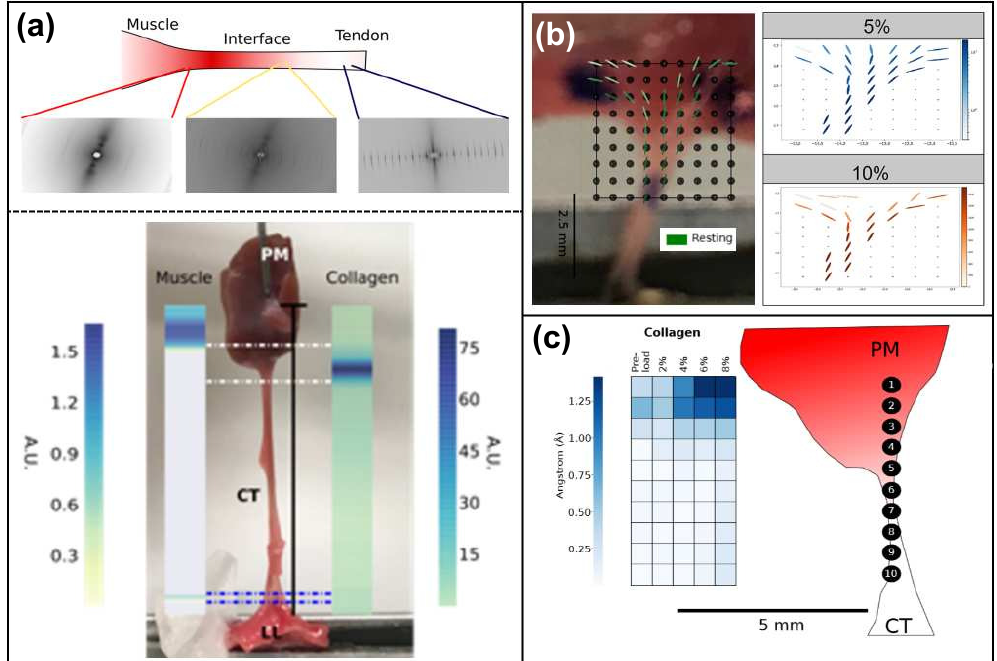
Figure 4. ( a ) XRD scanning process and relative tissue composition along CT–papillary muscle (PM) specimens, ( b ) collagen fiber orientation in the CT–LL specimens under 5% and 10% stretch and ( c ) D-period measurements in the CT–PM transition under